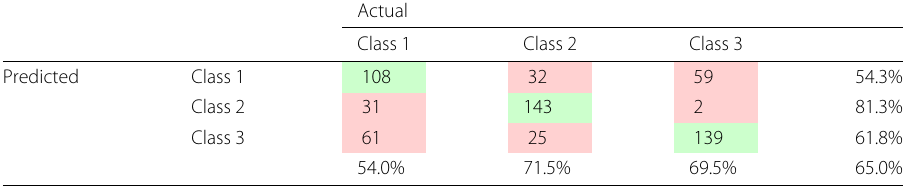
Table 4 Confusion matrix using features obtained with HANN ( N w = 32). Total classification accuracy is 65.0%